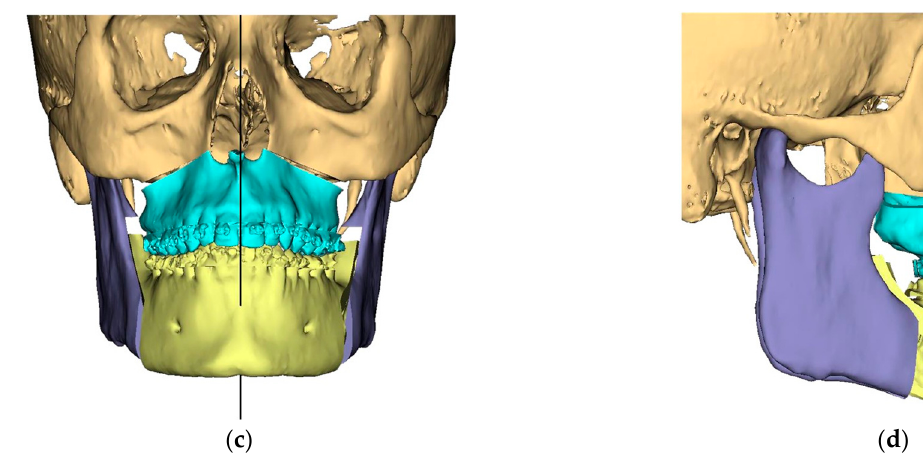
Figure 10. Surgical Plan: Before and After ( a ) Frontal view before; ( b ) Right side view before; ( c ) Frontal view after; ( d ) Right side view after.